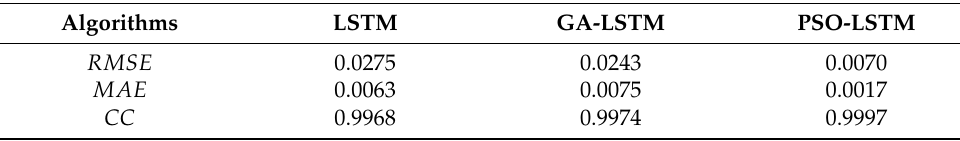
Table 3. Performance criteria of the temperature